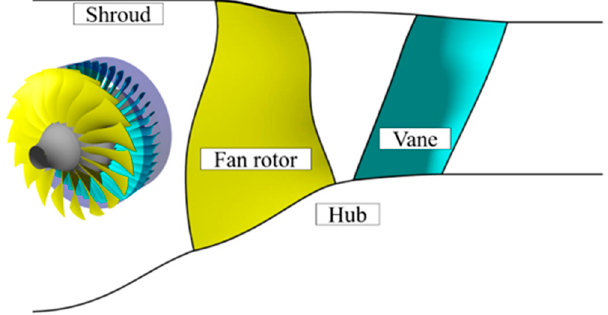
Figure 1. 3D and meridian surface diagram of the baseline fan. Table 1. Key geometric and aerodynamic parameters of the baseline fan.